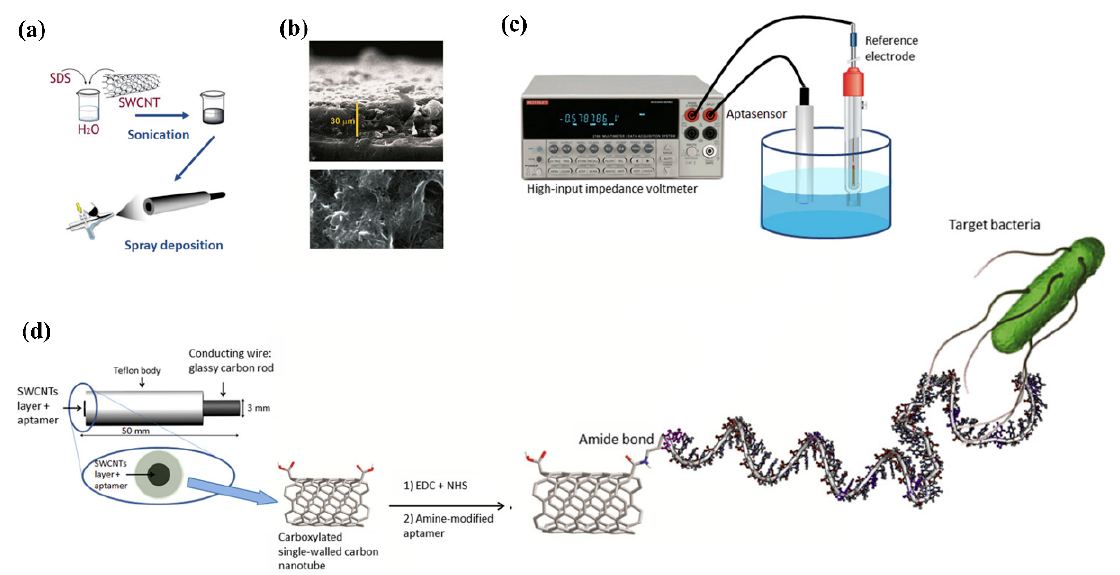
Figure 6. Fabrication of aptasensor on glassy carbon electrode (GCE). ( a ) Carbon nanotube deposition of on the surface of GCE; ( b ) Deposition of single-walled carbon nanotubes (SWCNTs) on GCE observed by (ESEM) environmental scanning electron microscope (representing a view from surface and lateral side). The surface view explains about the layer completely covering whole surface and the lateral view displays homogeneous height of the layer; ( c ) Potentiometric analysis; ( d ) Representation of an aptasensor for potentiometric analysis with specific aptamers functionalized with carboxylated SWCNTs and the correlation between the target bacteria and aptamer (Gustavo et al., 2013). Adapted with permission from Ref. [88]. Copyright 2013, Elsevier.